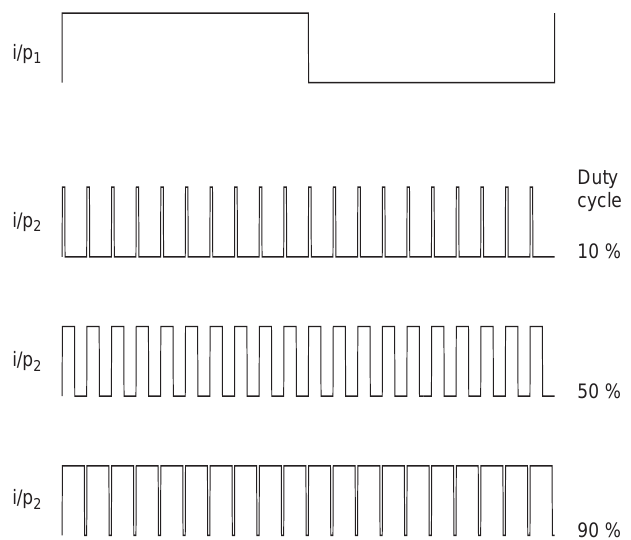
Fig. 2. ‘‘Sousy switch’’ gate input waveforms. i = p 1 – fundamental ELF waveform, typically 505 Hz. i = p 2 – variable duty cycle waveform (0–100%), typically 10.1 kHz